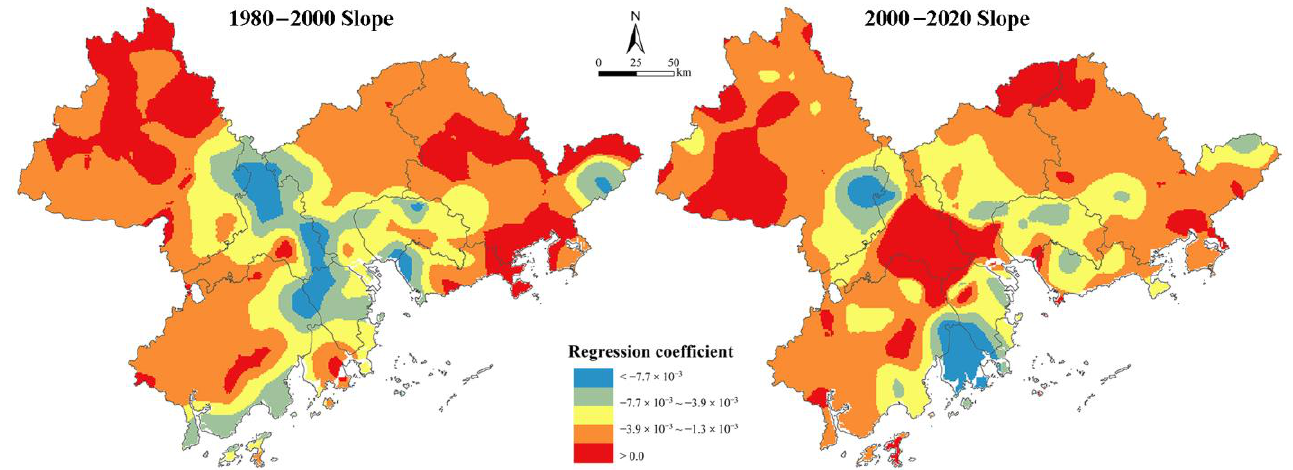
Figure 12. Spatial patterns of correlation between natural factors and habitat